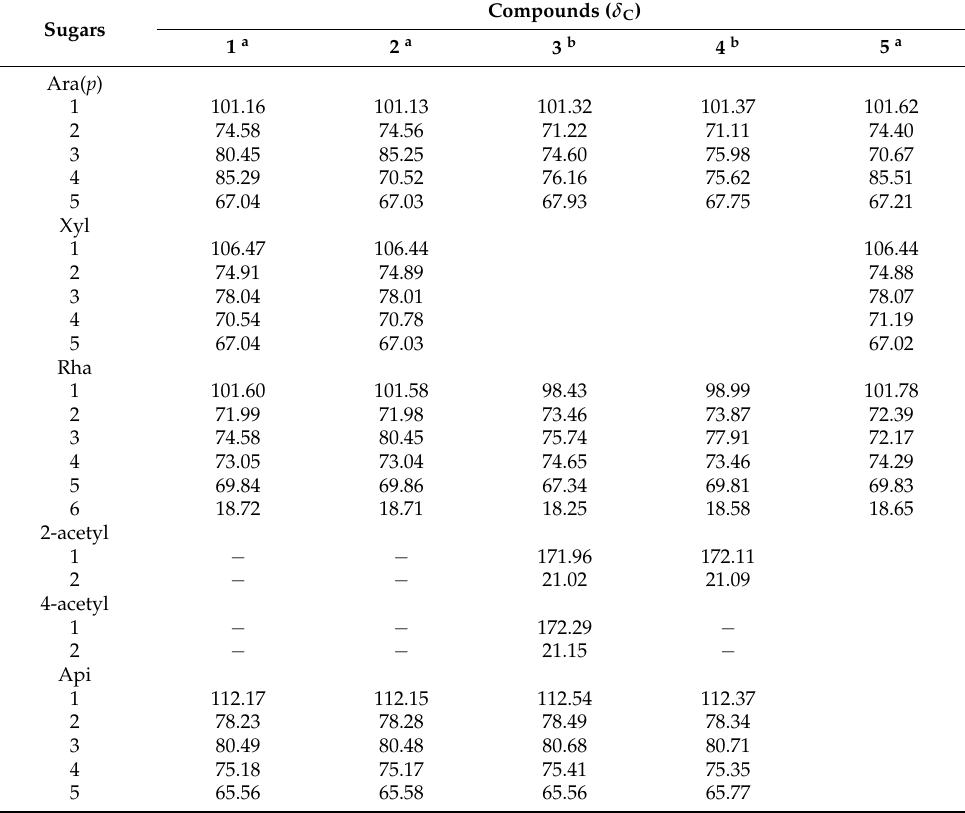
Table 3. 13 C-NMR data of sugar portion of compound 1 – 5 in CD 3